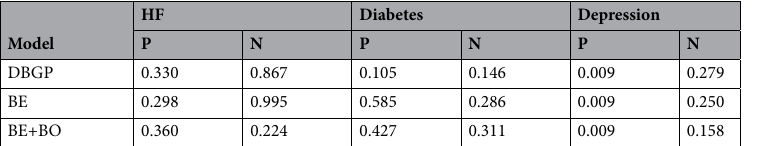
Table 2. Uncertainty divergence (DIV): DIV calculates the KL divergence between the std distributions of false positive and true positive predictions. P positive prediction, N negative prediction.